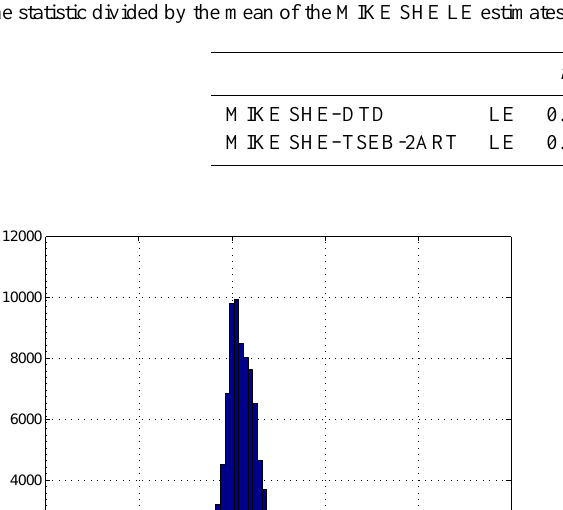
Table 3. Statistical comparison of catchment-wide latent heat fluxes estimated by the model pairs (MIKE SHE–DTD and MIKE SHE–TSEB- 2ART) for predominantly cloud-free days over the period of 8 years. Statistics used: correlation coefficient ( r ), root mean square difference (RMSD), relative RMSD (%RMSD), bias and relative bias (%bias). RMSD and bias are in Wm − 2 while %RMSD and %bias are calculated as the statistic divided by the mean of the MIKE SHE LE estimates and are percentages.